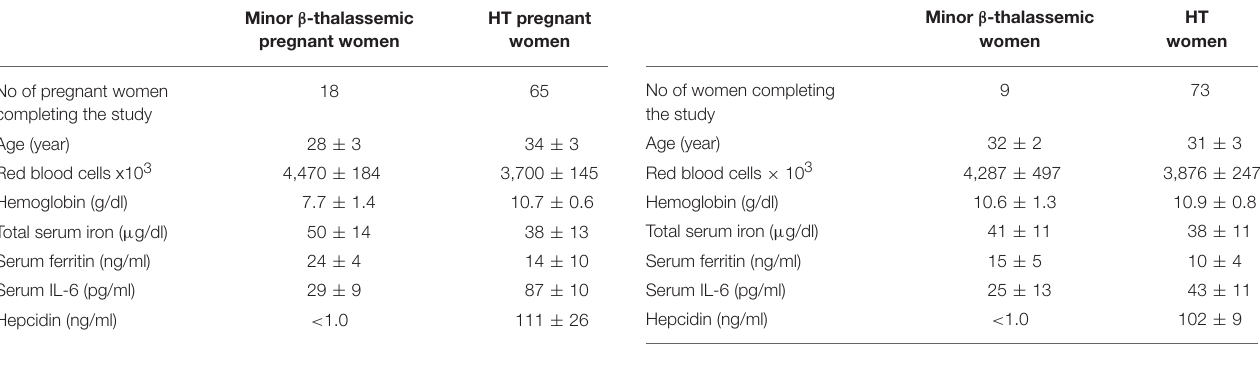
TABLE 3 | Demographics and baseline hematological mean values ± SD of minor β -thalassemic and HT women of child-bearing age affected by anemia and AI,